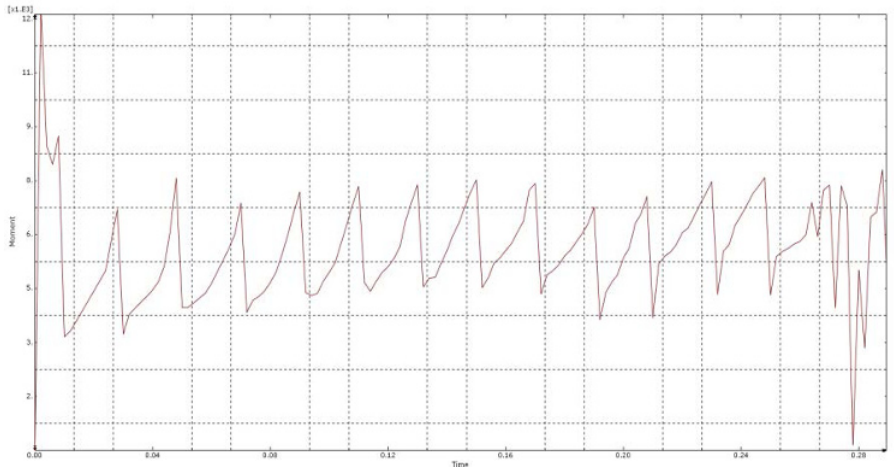
Fig. 6. Stripping bending moment curve of the sandwich